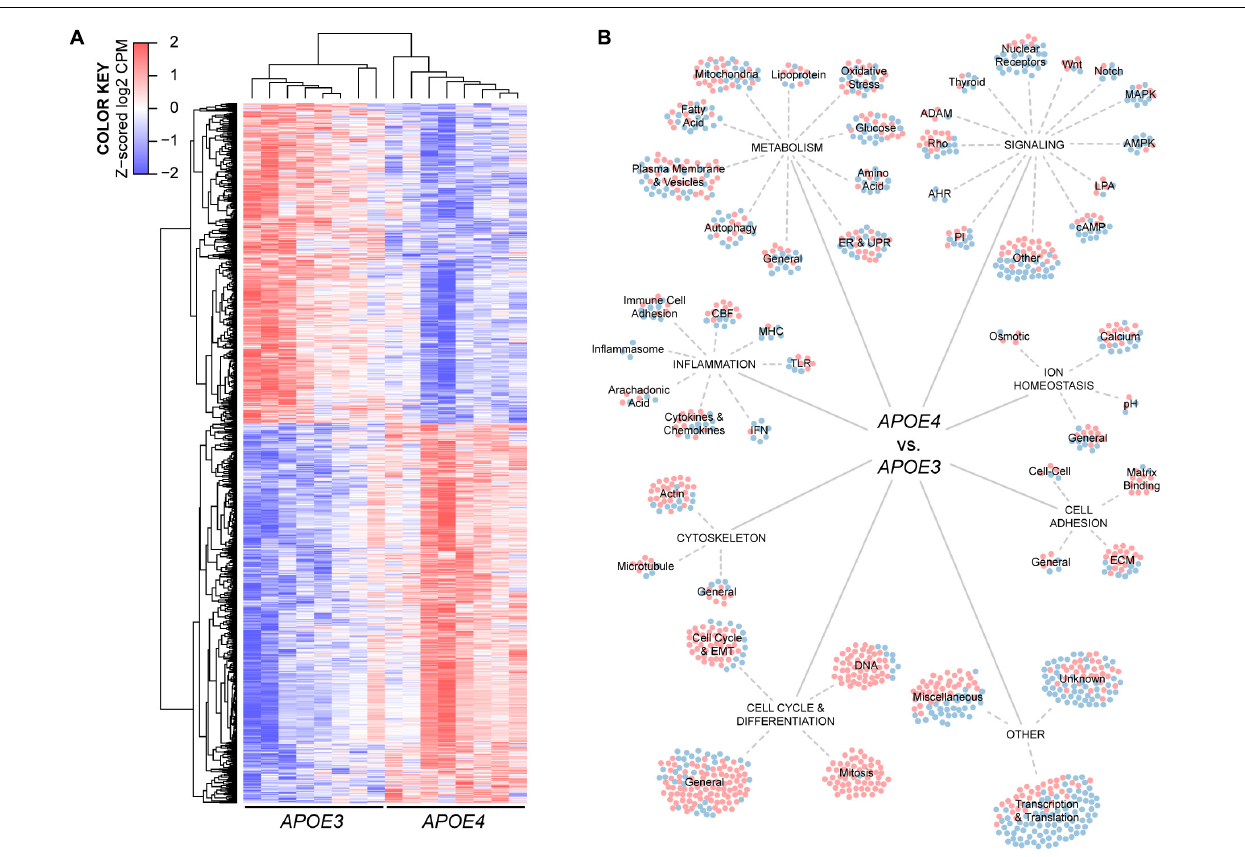
FIGURE 3 | Human APOE genotype modulates the transcriptional phenotype of brain endothelial cells. (A) Hierarchical cluster analysis of 1304 differentially expressed genes in APOE4 brain endothelial cells determined by RNA-sequencing analysis, n = 8. (B) Manual categorization of the differentially expressed